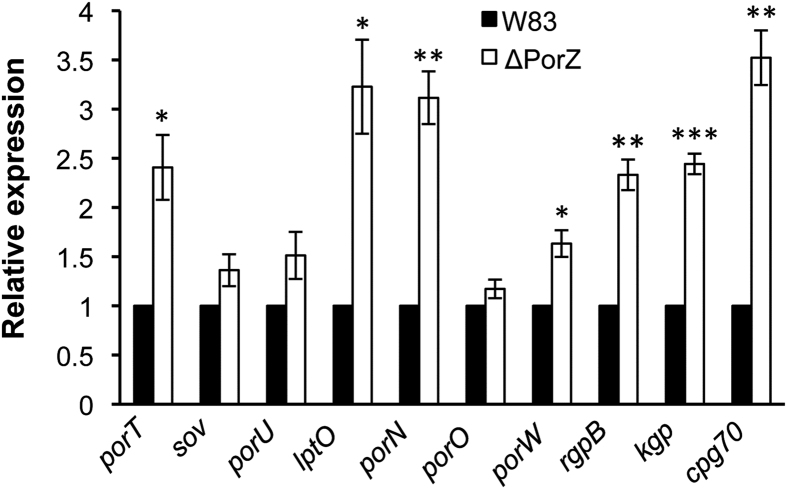
Effect of PorZ on the expression of T9SS components and cargos.The respective mRNAs of the genes of T9SS components (porT, sov, porU, lptO, porN, porO and porW) and cargos (rgpB, kgp and cpg70) were quantified in mid-logarithmic cultures of wild type (W83; full bars) and ΔPorZ (open bars) cells by quantitative RT-PCR. Expression levels were normalized against ribosomal r16s expression, and the respective expression levels of the wild type were arbitrarily set to 1.0. The results correspond to four independent experiments. Error bars represent standard deviation as analyzed by Student’s t-test. *P < 0.05; **P < 0.01 and ***P < 0.001.